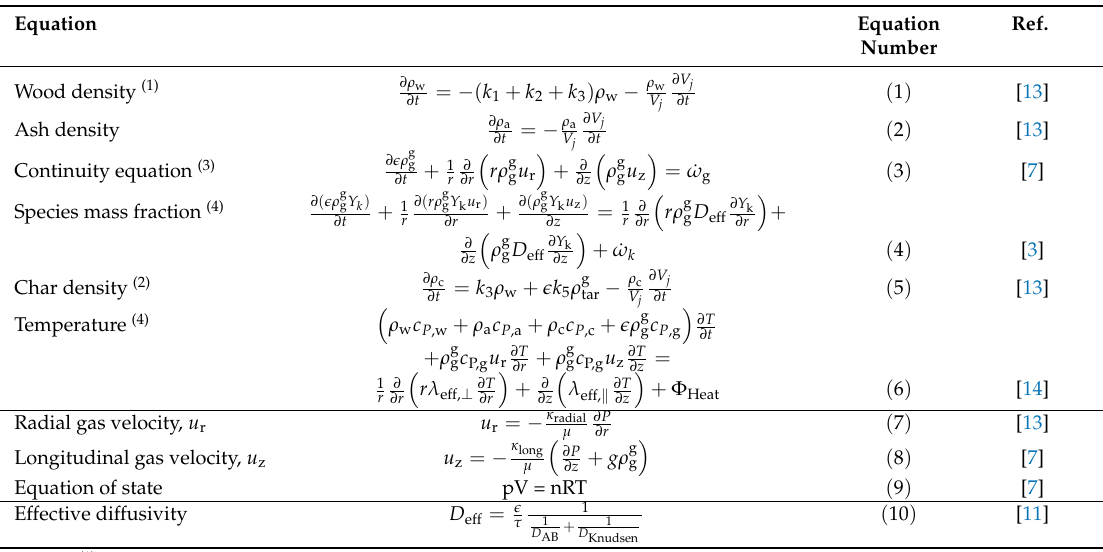
Table 1. List of evolution equations required for the devolatilization model. The last column gives the references the equations have been taken